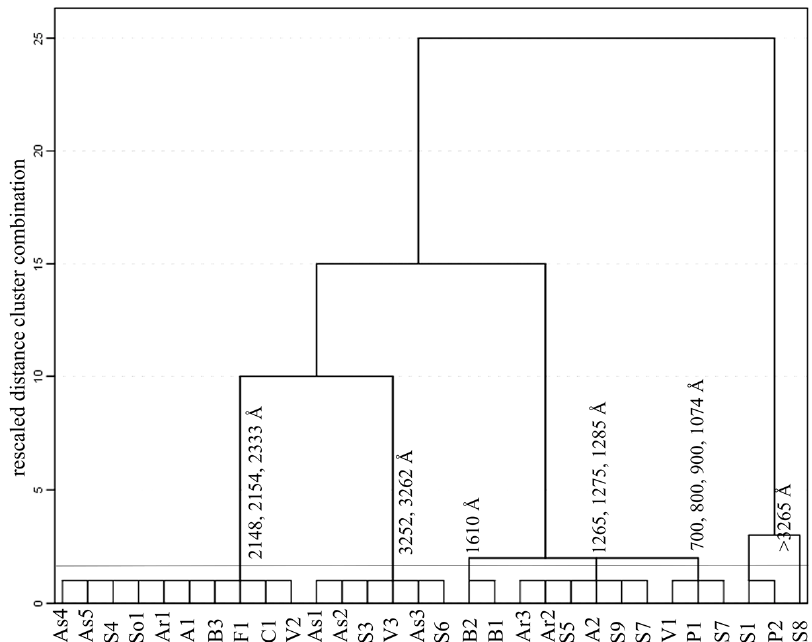
Figure 12. Dendrogram of crystallite size of outcrop samples using the Ward method and the Euclidean distance as measurement range.